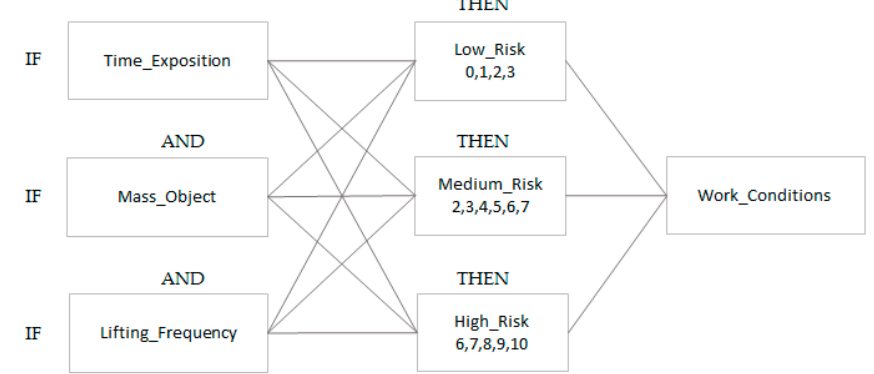
Figure 2. Grid diagram of work conditions (variables) for level (choices). Table 4. Fuzzy rules.